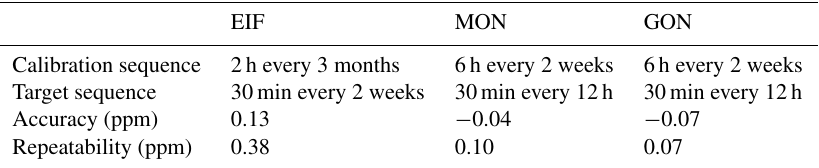
Table 2. Calibration and target frequencies, accuracy and repeatability of the CO 2 -MegaParis stations. The accuracy is given as the difference of the target CO 2 concentrations measured by the CRDS analyzer and the